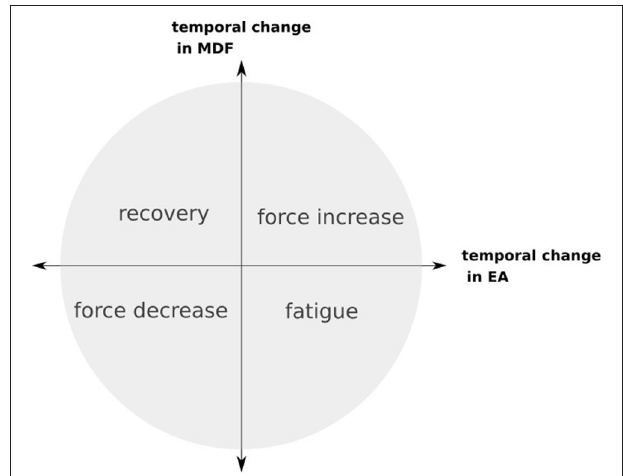
FIGURE 1 | Graph representing algorithm in Luttmann et al. (2000). Increase of EA with shift of median frequency (MDF) to the higher frequencies corresponds to force increase whereas increase in amplitude and shift to the lower frequencies indicates muscle fatigue. Similarly a decrease of the EA with simultaneous shift to the lower frequencies of the median frequency indicates force decrease whereas shift to the higher frequencies recovery from fatigue.